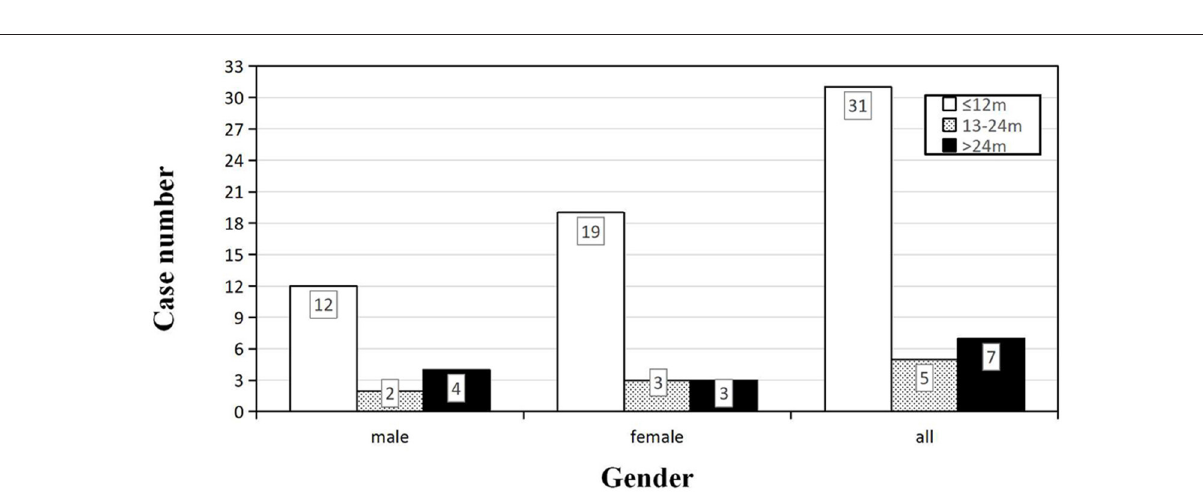
FIGURE 4 | Distribution of the survival time among sCJD patients stratified by gender ( n = 43). For both male and female, the largest proportion of patients had a survival time within 1 year, indicating that the survival time may not be necessarily related to the